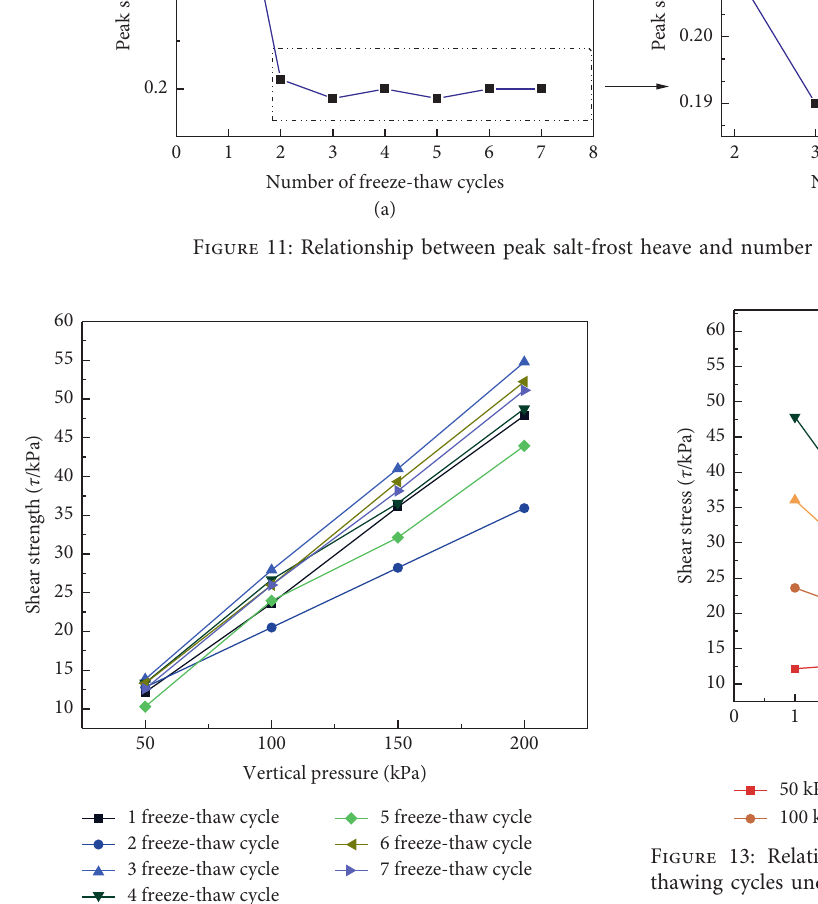
Figure 12: Relationship between shear strength and vertical pressure under different freezing-thawing cycles.